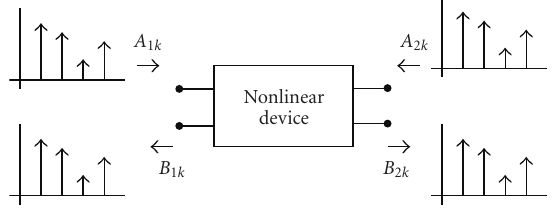
Figure 2: Scattering wave